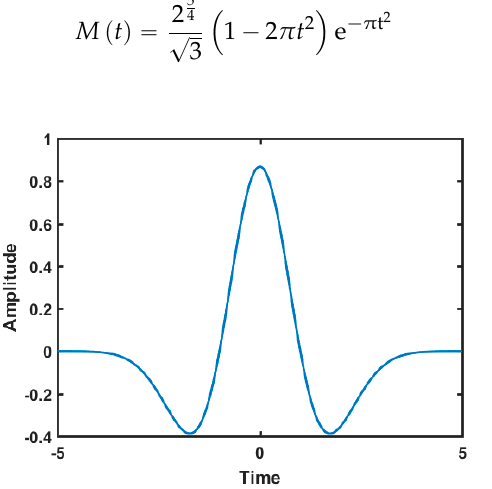
Figure 6. Mexican Hat mother wavelet.